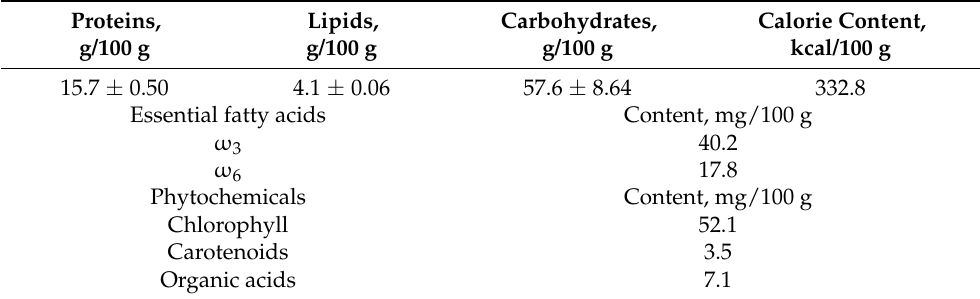
Table 7. The nutritional value of pasta with the addition of microalgae Chlorella sorokiniana dry biomass (5% by weight of the flour